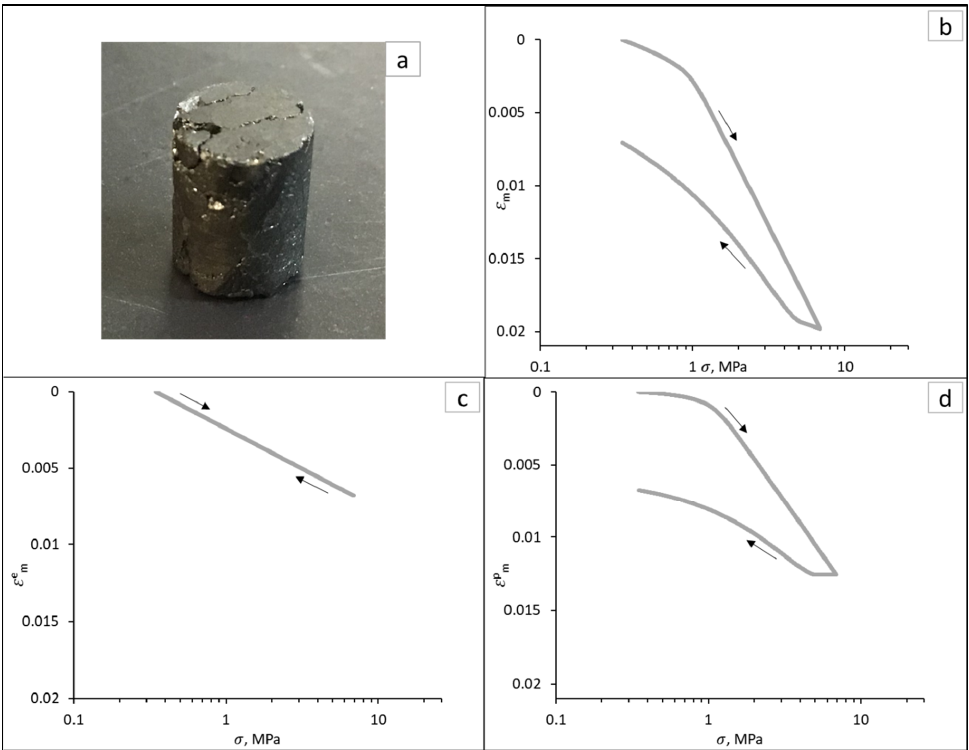
Figure 20. Photo and calculation of coal sample 3 (test 3).